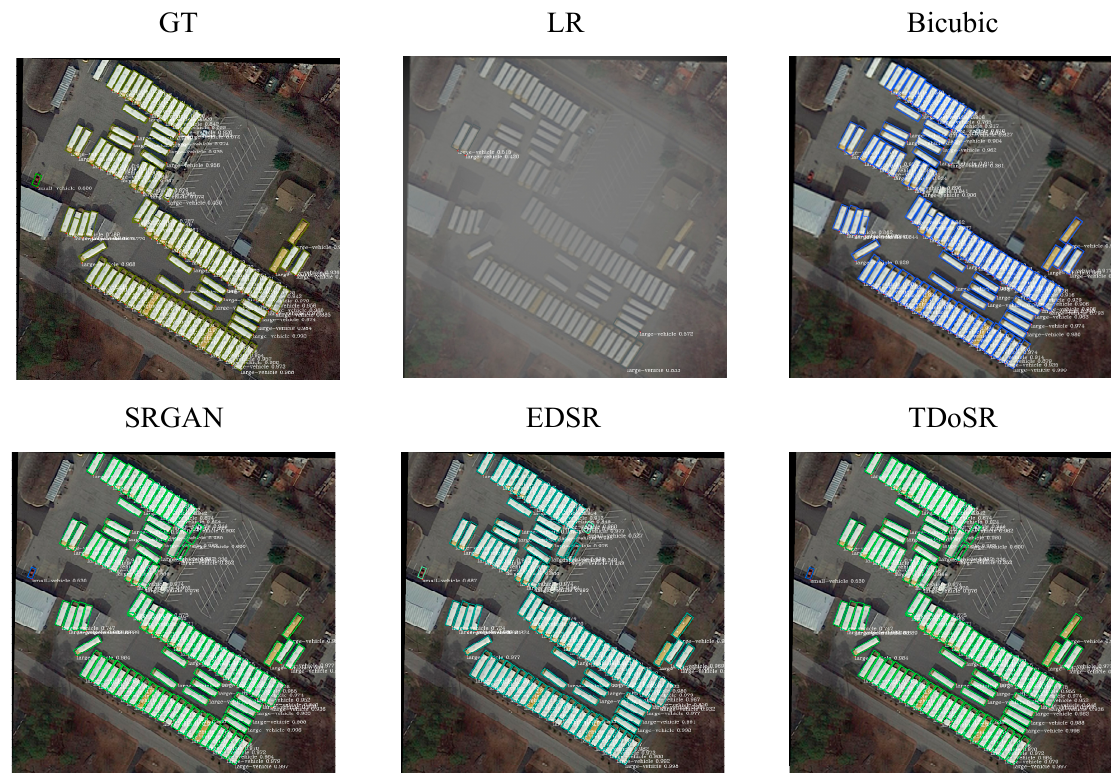
Figure 5. Recognition effect diagram of different methods.